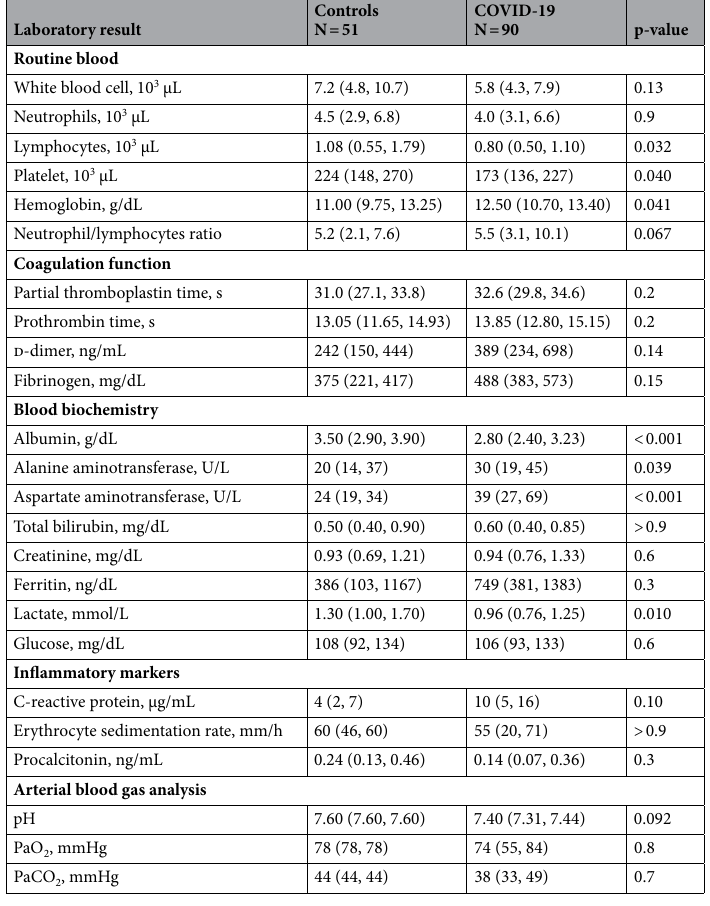
Table 2. Initial laboratory results within 72 h of admission of COVID-19 patients and